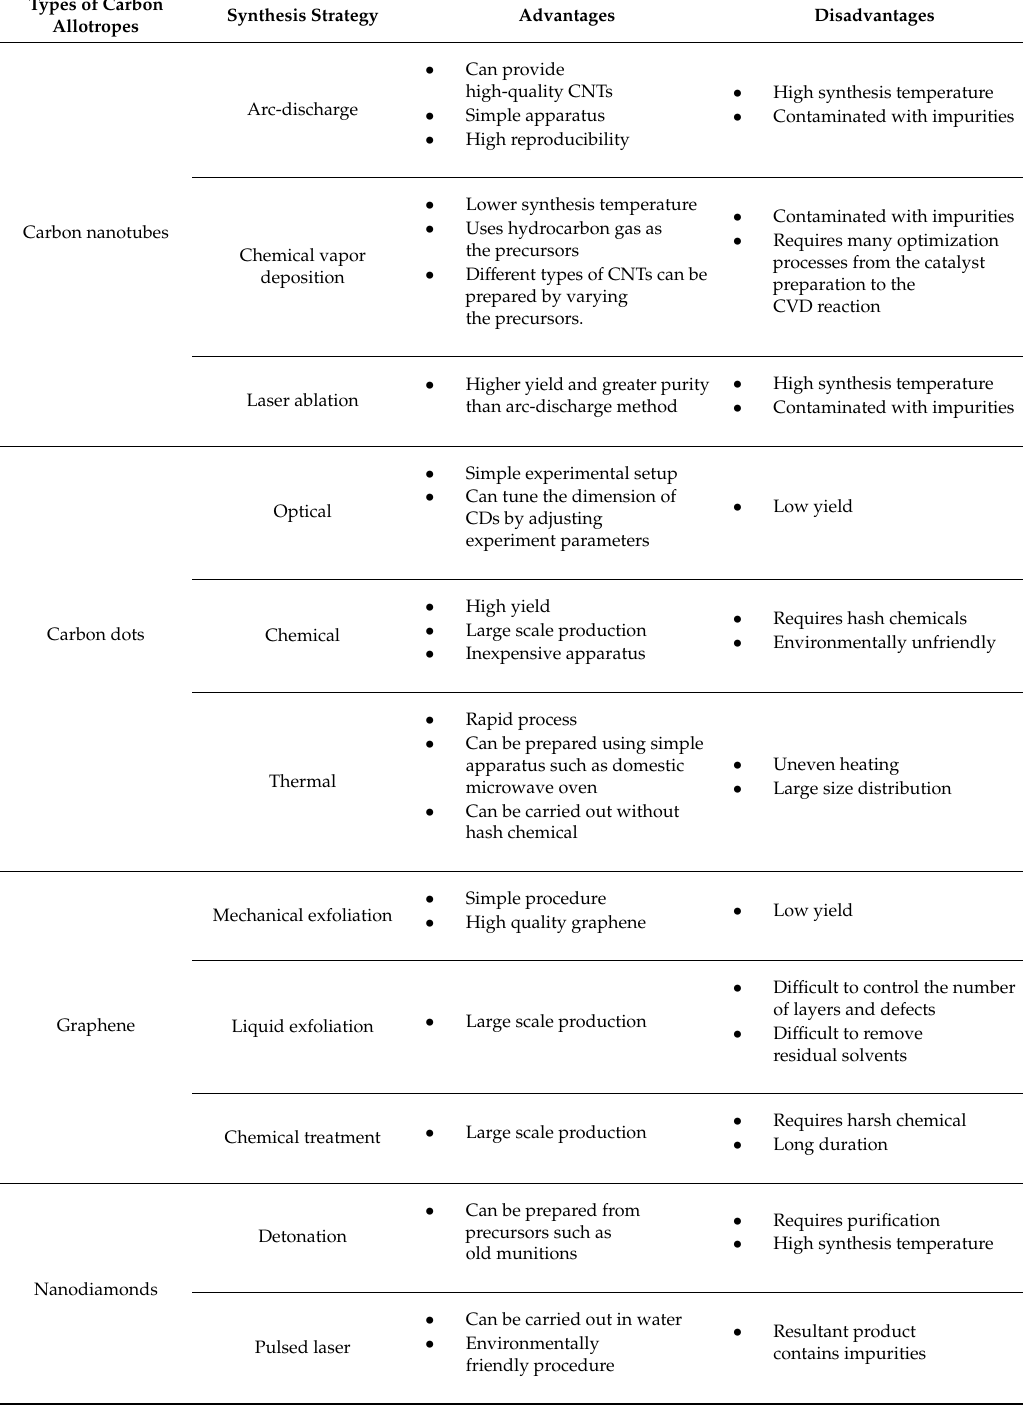
Table 2. Comparison of synthesis approaches for carbon